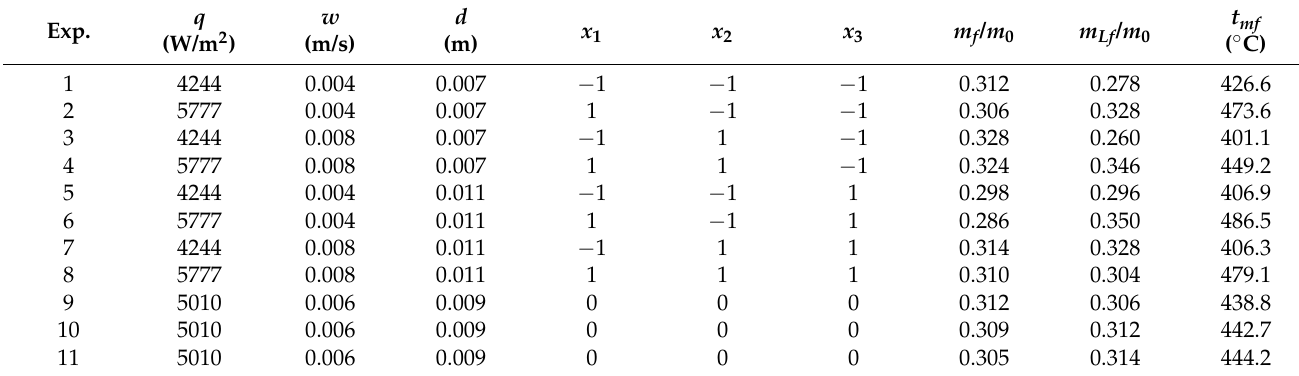
Table 1. Levels of process factors and